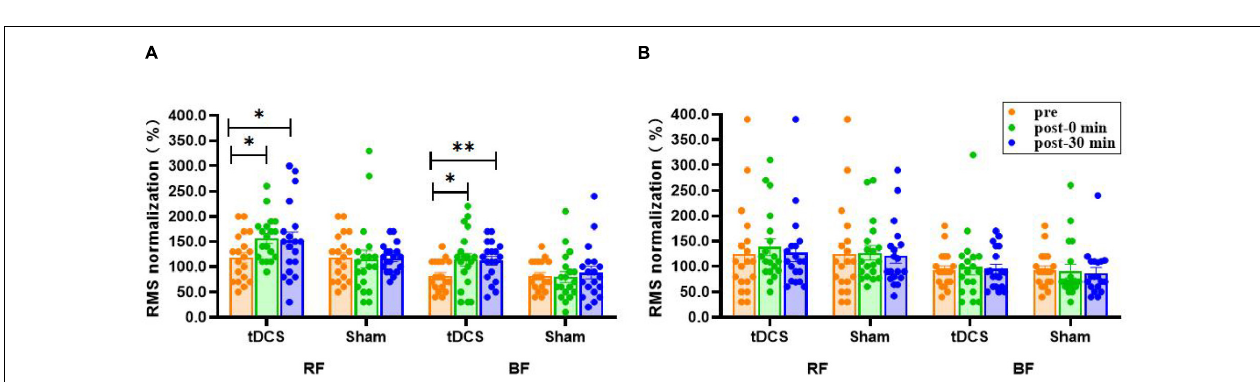
FIGURE 4 | Effects of tDCS on maximal voluntary contraction of left (A) and right (B) knee flexors and extensors. pre: prestimulation, post-0 min: 0 min after stimulation, post-30 min: 30 min after stimulation. Data are presented as mean ± SEM. Asterisks ( ∗ ) indicate statistically significant difference compared to prestimulation ( ∗ P < 0.05, ∗∗ P < 0.01). Well number (#) indicates statistically significant difference compared to sham ( # P < 0.05).